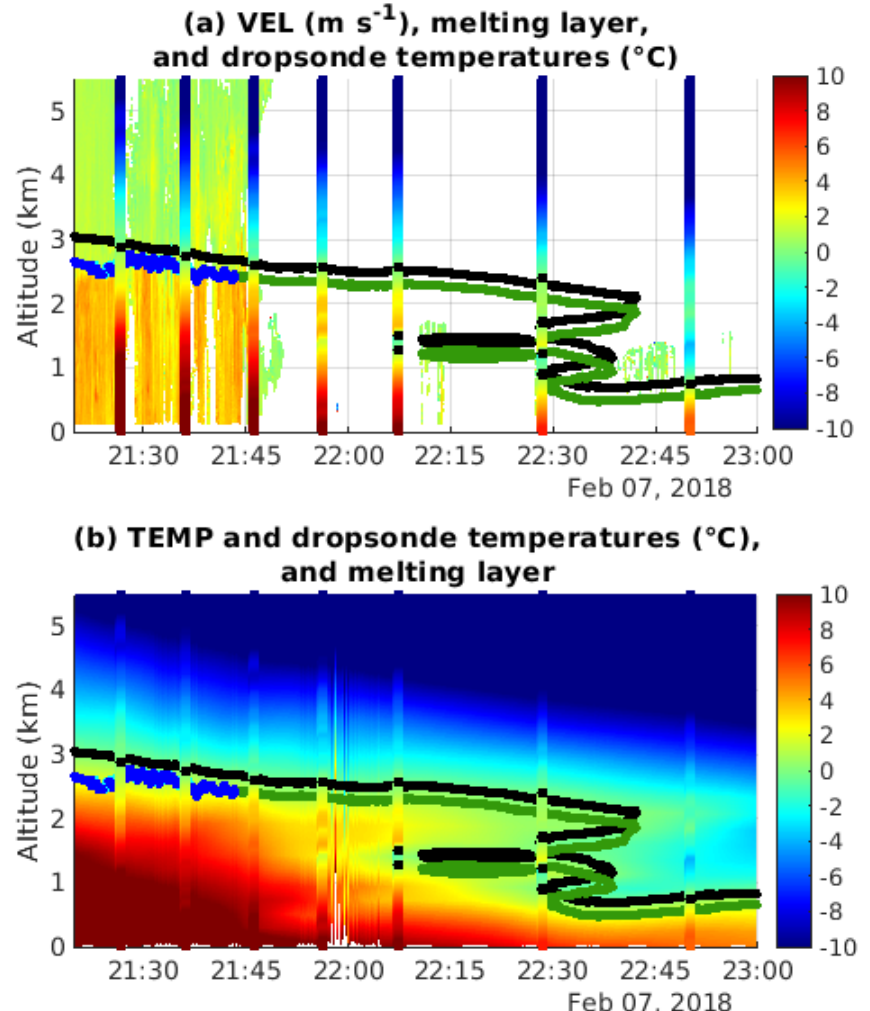
Figure 9. Example comparing melting layer (colors as in Figure 5) and ERA5 temperature with dropsonde temperatures. Vertical columns show dropsonde temperatures with black dots within the vertical columns indicating 0 °C data points. Background fields are ( a ) radial velocity and ( b ) ERA5 temperatures. Times are in UTC.